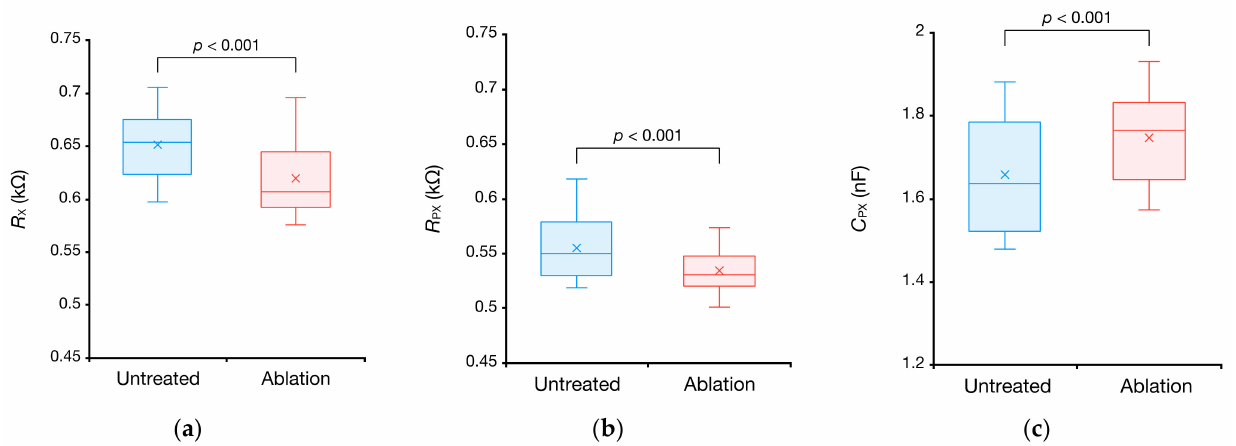
Figure 16. Comparison of equivalent circuit parameters between the untreated and ablated left ventricles of porcine hearts: ( a ) R X , ( b ) R PX , and ( c ) C PX . The sample size is